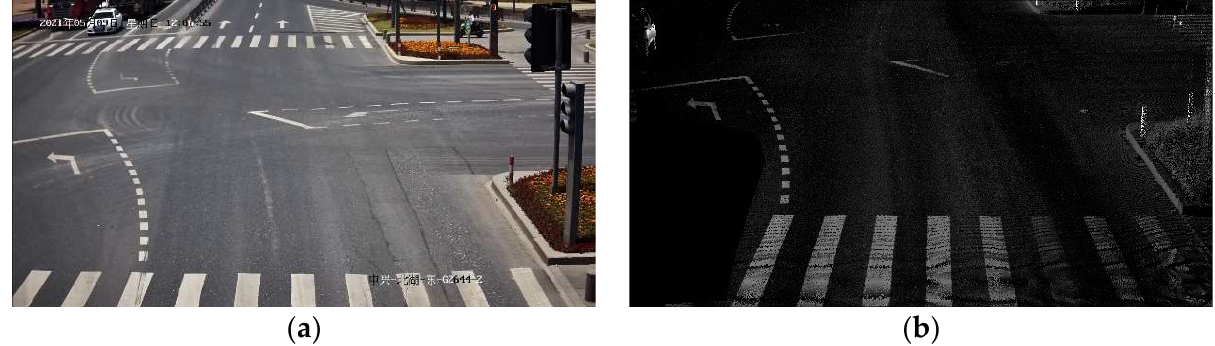
Figure 8. Experimental data for parameter study. ( a ) screenshot of video taken by roadside camera; ( b ) The point cloud intensity image at the location of ( a ) was taken.